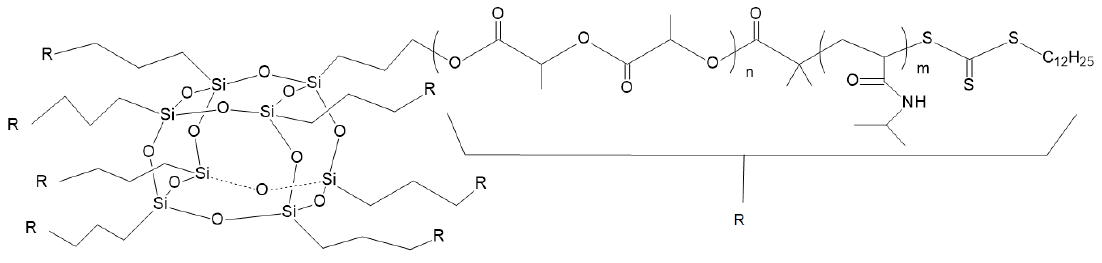
Figure 21. Structure of POSS(PLLA-b-PNIPAM) block copolymer [81].